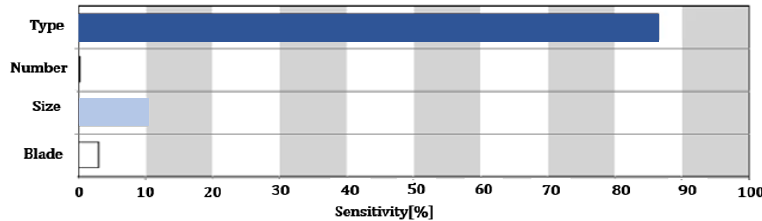
Figure 9. Sensitivity plot of stress.